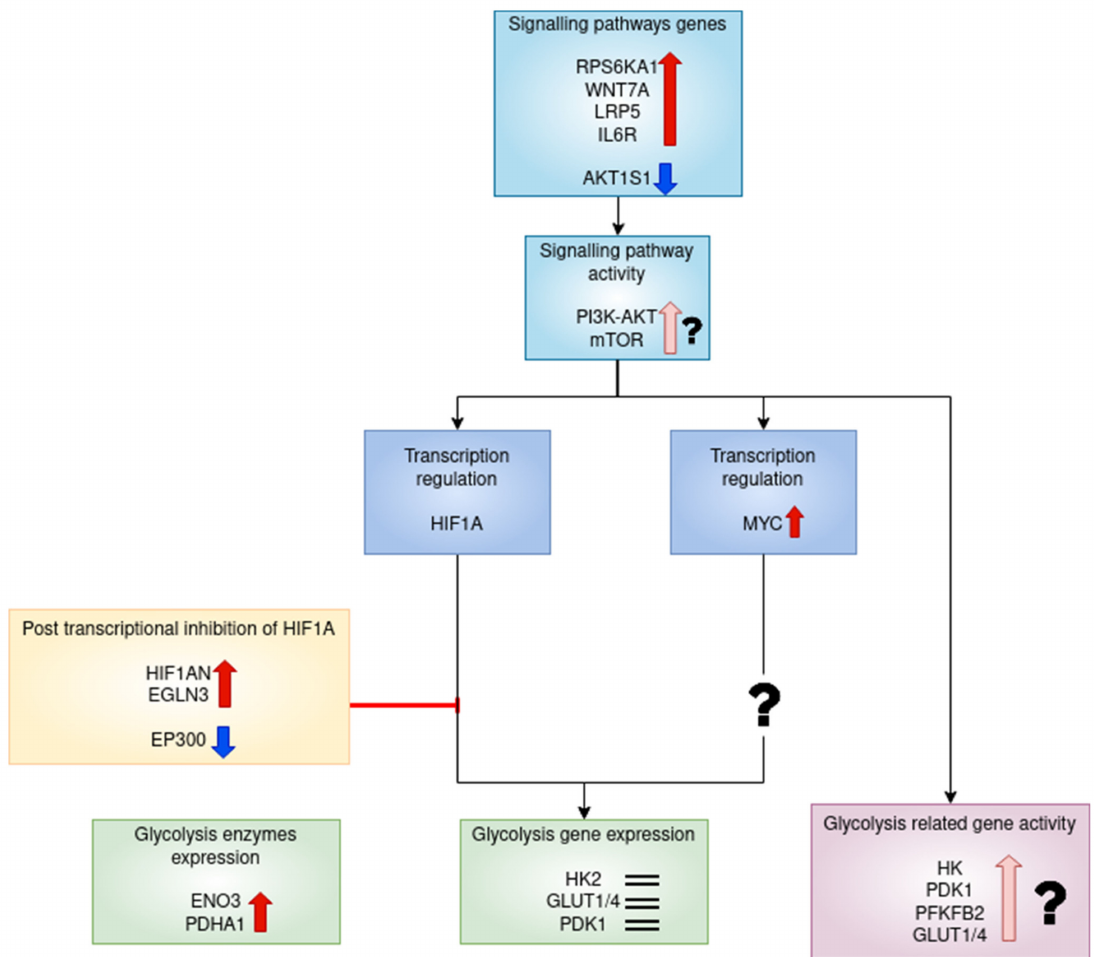
Figure 22. The differentially regulated genes involved in the regulation of glycolysis in RA CD8 + Temra cells. Post transcriptional inhibition of HIF1A by the upregulated ELOB and EGLN3 (red up arrow) and the downregulation of HIF1A co-activator EP300 (blue down arrow) inhibit HIF1A activity. AKT1S1 is downregulated (blue down arrow), while RPS6KA1 , IL6R , WNT7A and LRP5 are upregulated (red up arrow) upstream of mTOR. AKT and mTOR may be activated in RA CD8 + Temra cells (light red up arrow and question mark). This may be the cause of the upregulation of MYC (red up arrow). Glycolysis target genes of MYC and HIF1A do not show differential regulation (black = signs). AKT and mTOR activity may increase the activity of glycolysis genes HK , PDK1 , PFKFB2 and GLUT1-4 (light red up arrow and question mark). ENO3 and PDHA1 are upregulated (red up